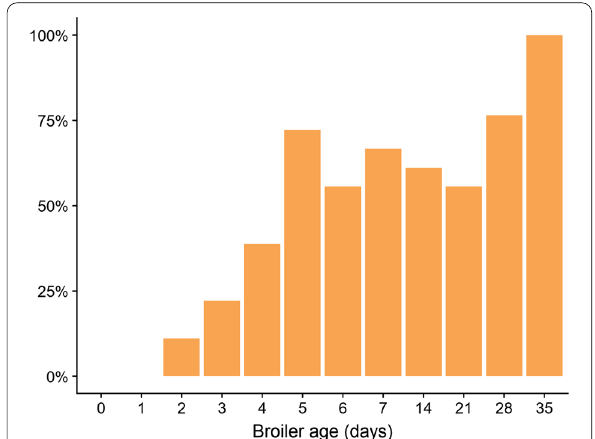
Fig. 1 ESBL -E.coli prevalence throughout the broilers’ life